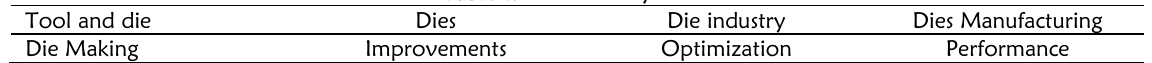
Table 1: Searched keywords